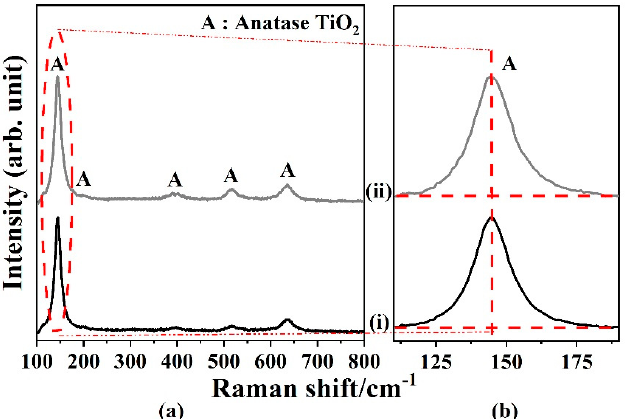
Figure 8. ( a ) Raman spectra for TNTs annealed in (i) air and (ii) nitrogen. ( b ) Enlarged Raman patterns for anatase peak at 144 cm − 1 . Annealing was conducted at 450 ◦ C for 3